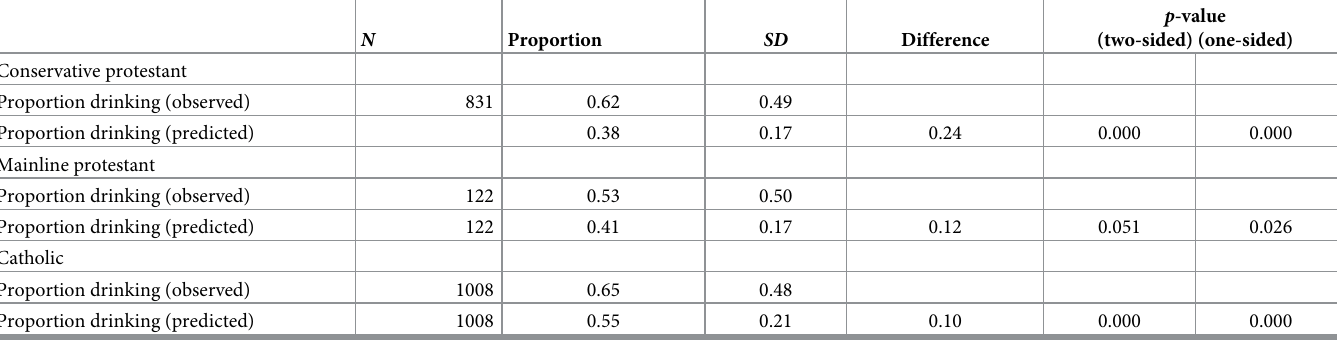
Table 2. Tests of proportions of observed against predicted drinking for cases with guaranteed boundary violation by religious